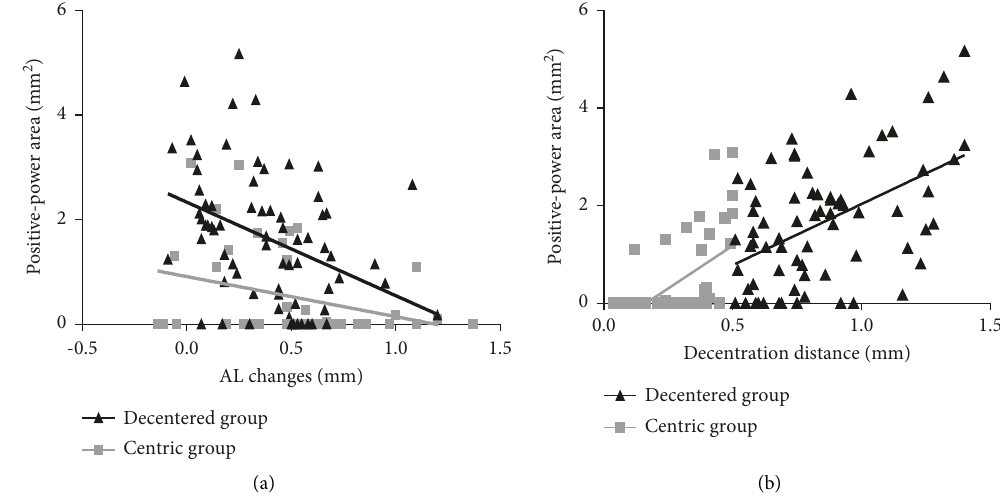
Figure 4: Correlation analysis of AL change and decentration distance with the positive-power area in the centric group and decentered group ((a) correlation between AL change and positive-power area in the centric group and decentered group; (b) correlation between decentered distance and positive-power area in the centric group and decentered